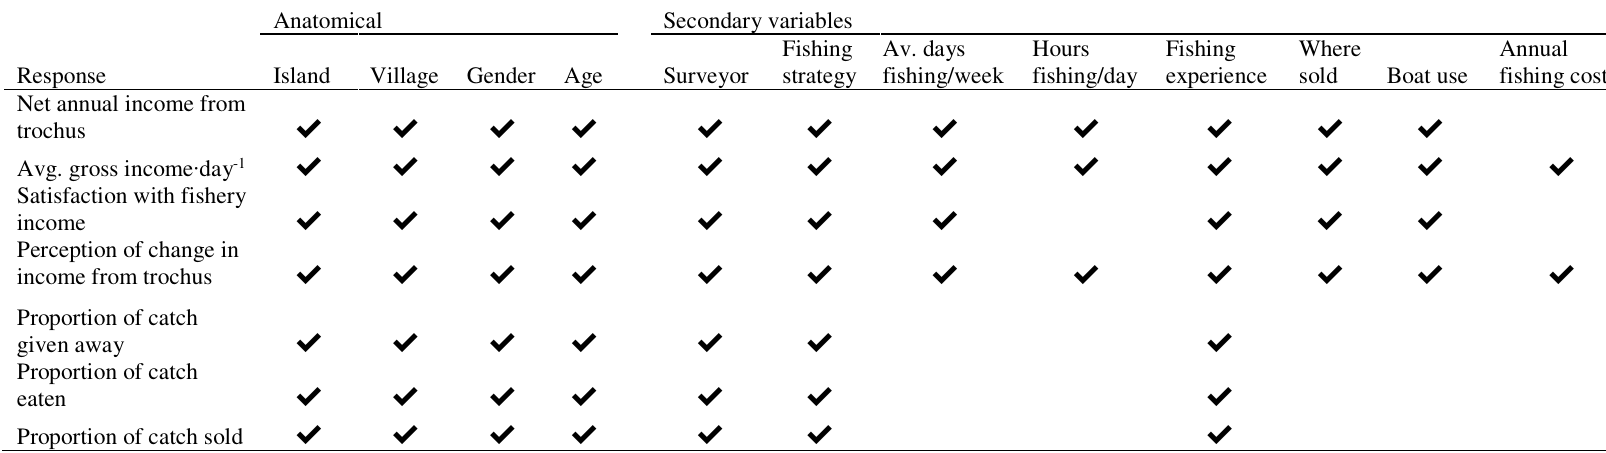
TABLE A2.1 | Summary of potential factors and covariates in the analysis of the response variables for the trochus data. Ticks denote the explanatory variables included in the analysis of each response